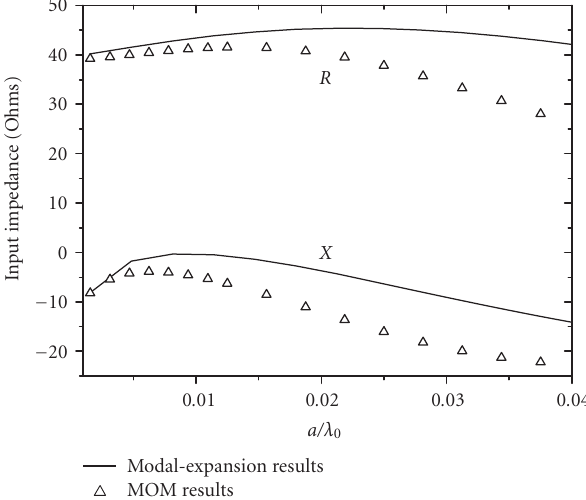
Figure 6: Variation of S -parameters of a two-monopole antenna with respect to their separation ( f = 0.9375 GHz).